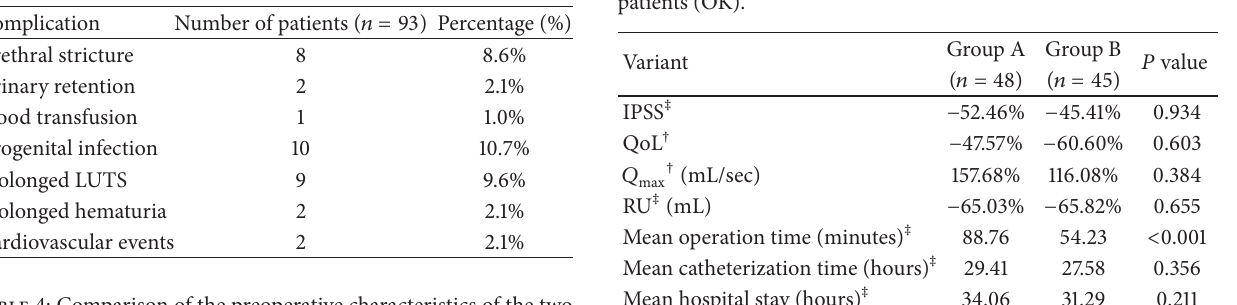
Table 4: Comparison of the preoperative characteristics of the two groups of patients.